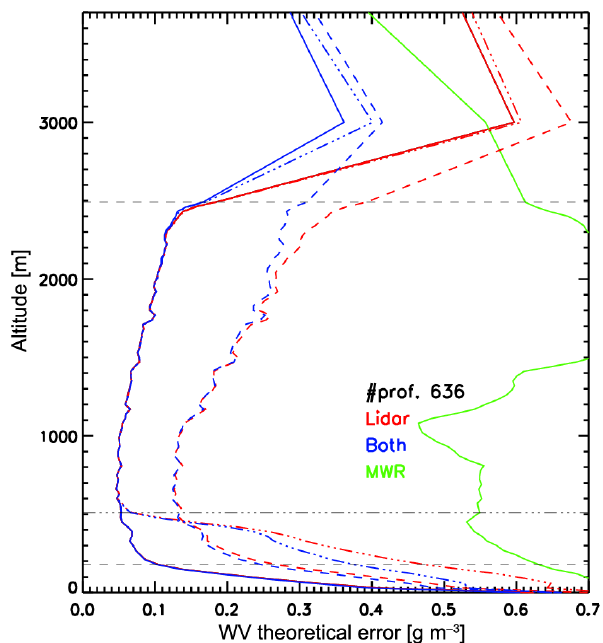
Figure 10. Mean theoretical error over 636 clear sky cases during the complete HOPE period. Red: only RL has been introduced in the algorithm. Green: only-MWR. In blue, the combination of RL and MWR. The dashed horizontal black lines define the region where lidar data have been considered available. The dashed red and blue lines represent the result when the lidar uncertainty has been in- cremented by a factor of 4. The dotted-dashed red and blue lines correspond to the case where lidar data have been suppressed from ground until 500m. Solid lines show the errors without increments, as shown in Fig.